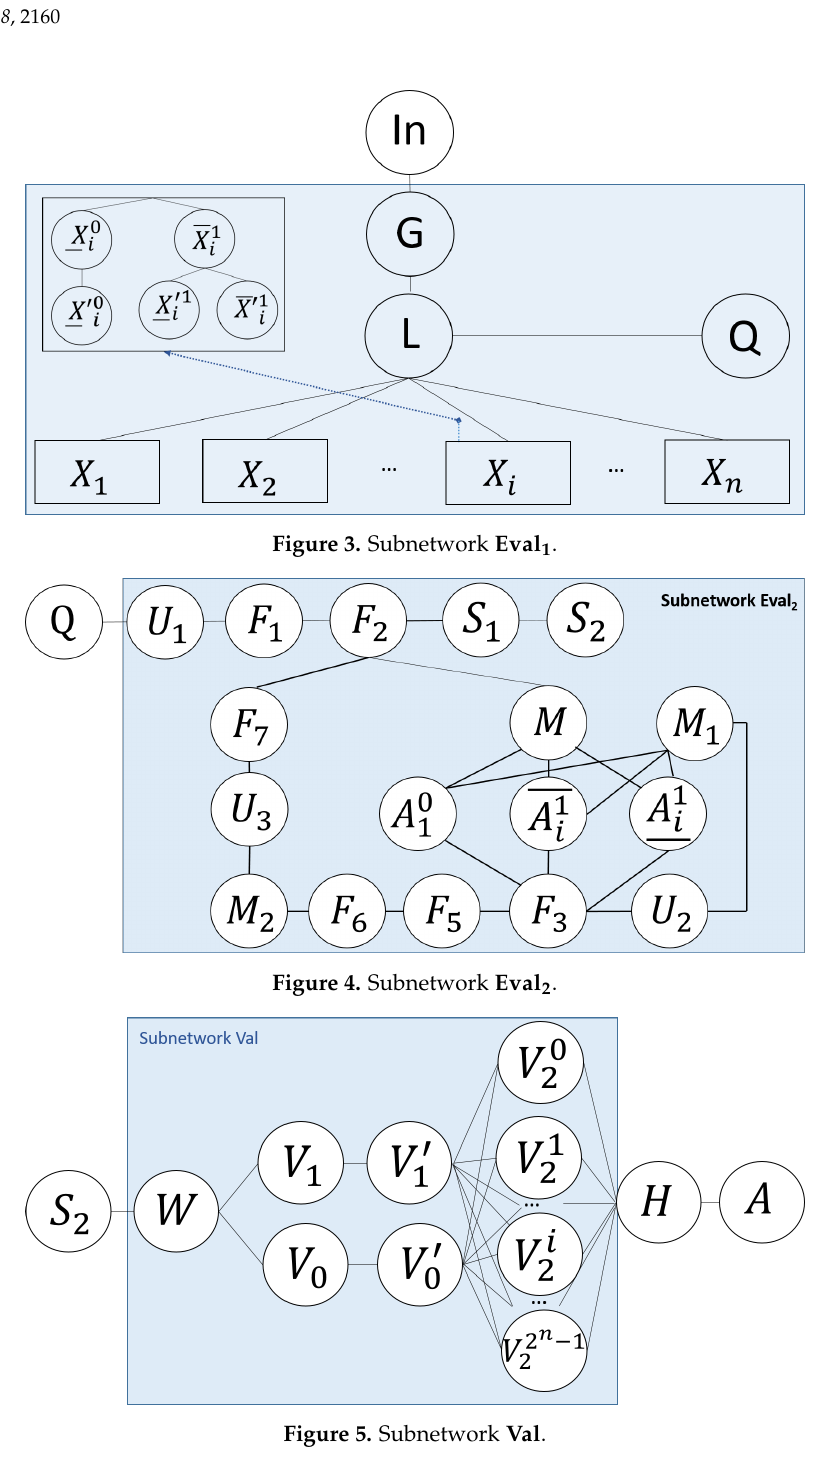
Figure 5. Subnetwork Val